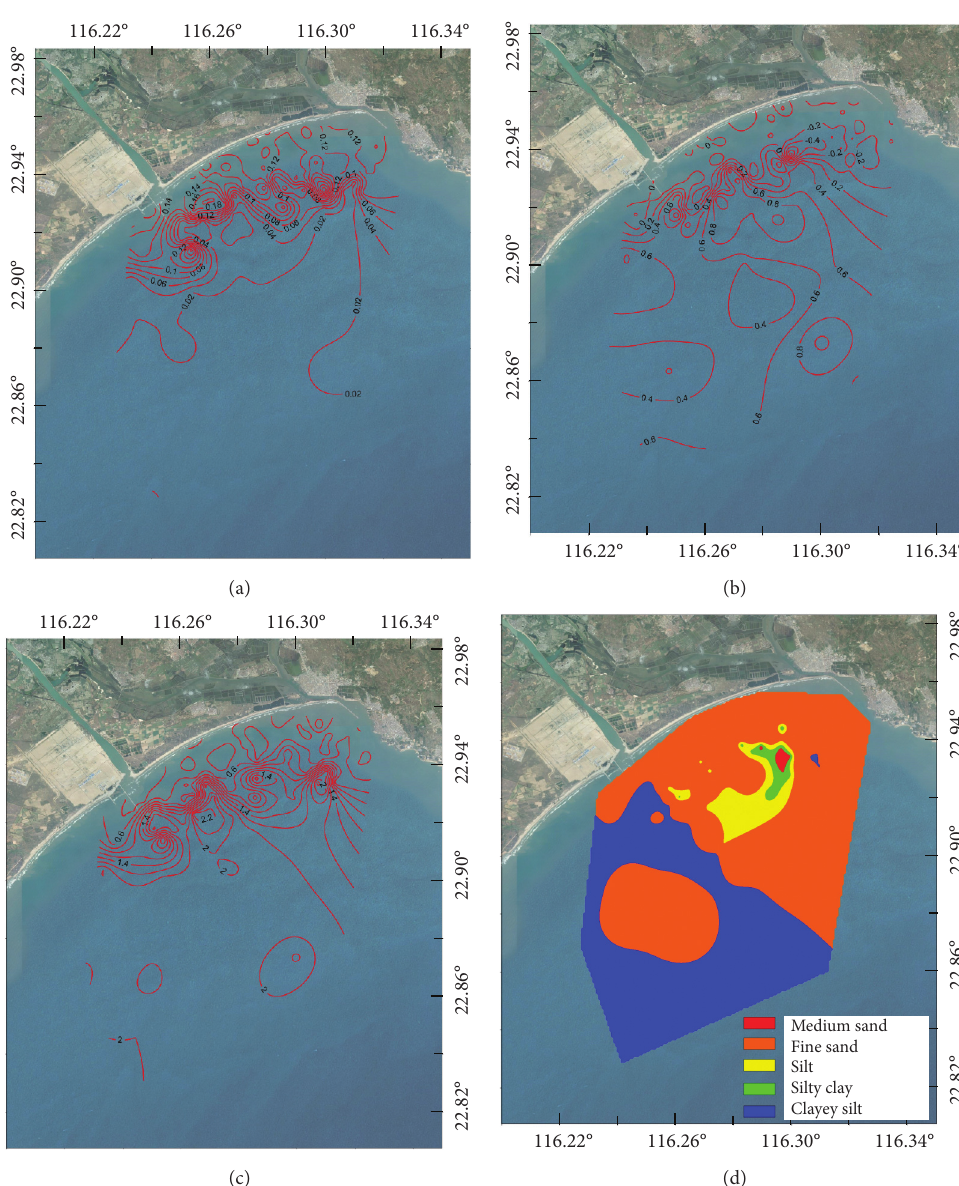
Figure 9: The distribution of the sediment in the study sea region. (a) The median particle size distribution of the sediment; (b) sorting degree distribution of the sediment; (c) the value of the skew distribution of the sediment; (d) the distribution of the classification of the